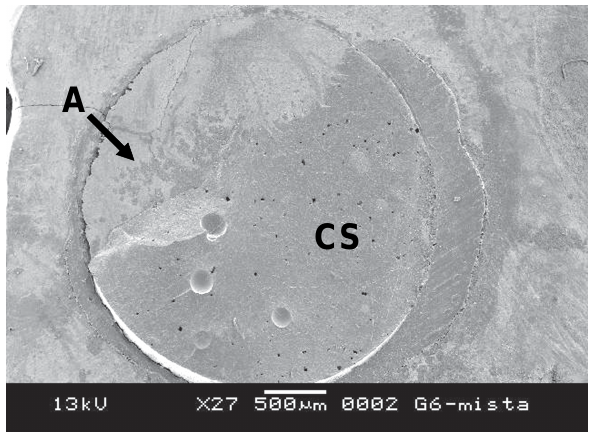
FIGURE 1- SEM photomicrograph illustrating a mixed failure for Group 1 (A – adhesive; CS – cohesive in sealant)